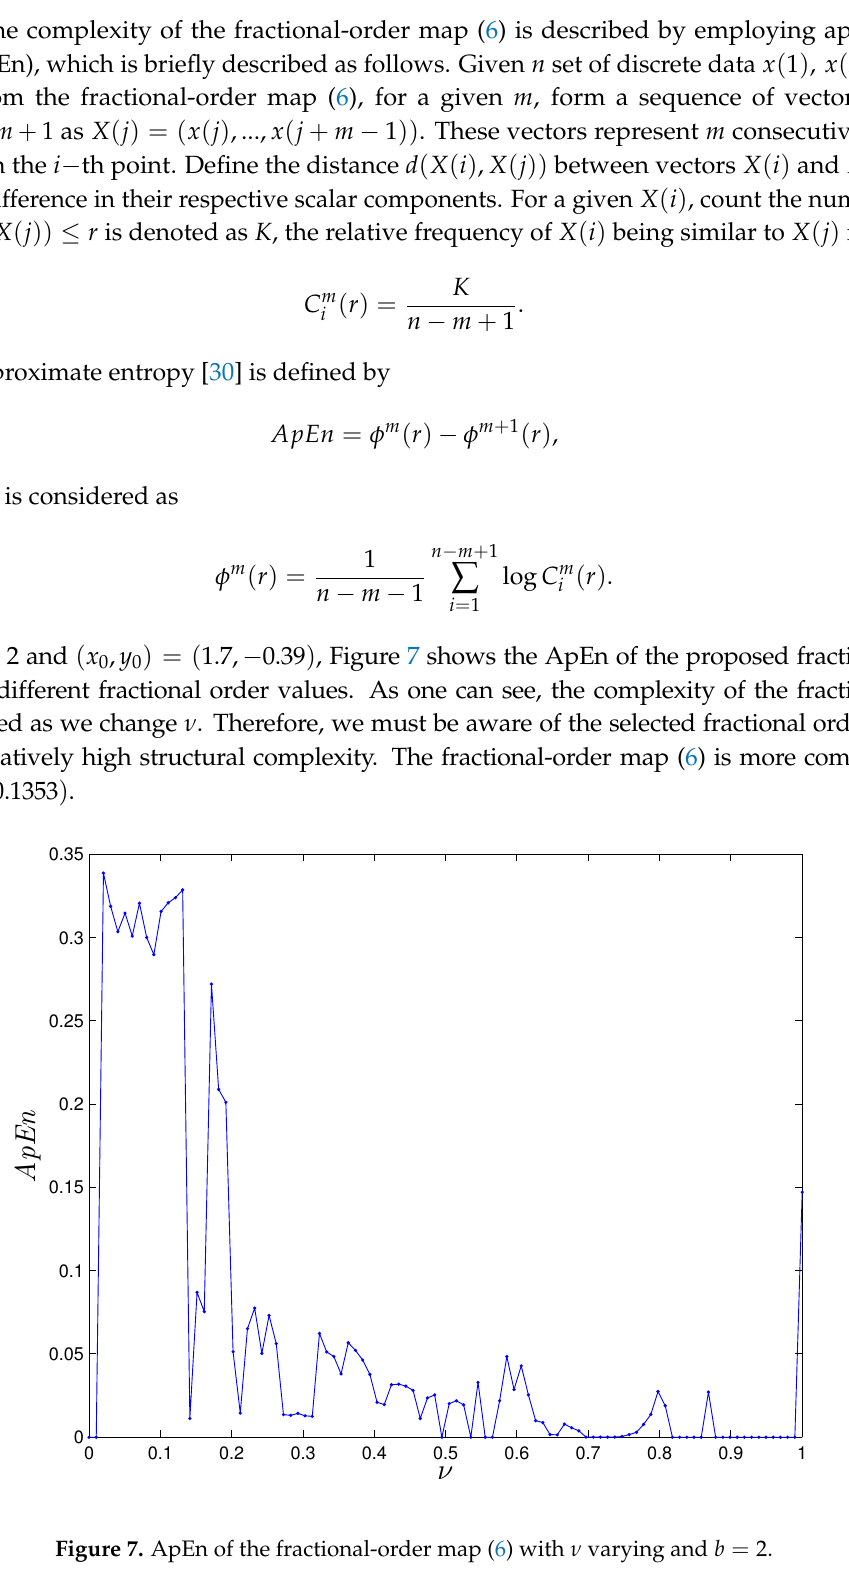
Figure 7. ApEn of the fractional-order map (6) with ν varying and b =